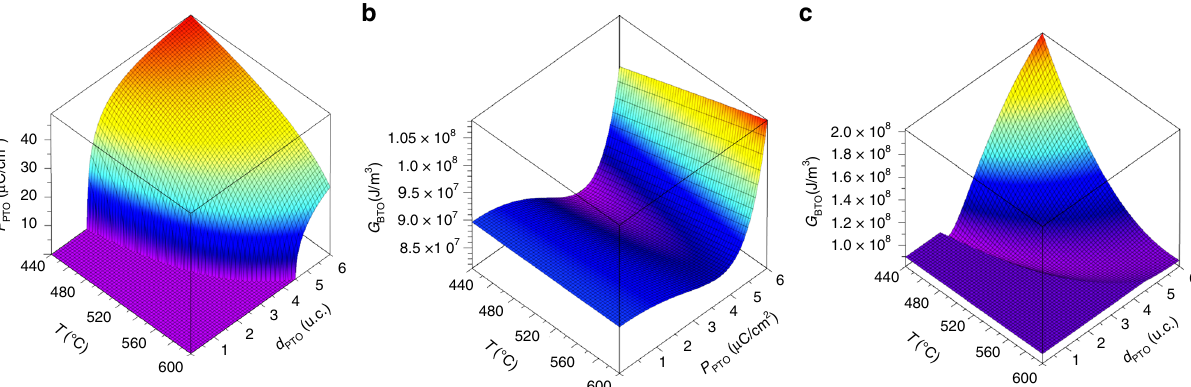
Fig. 2 Explanation of growth rate through free energy of BTO. Explanation of growth rate through free energy of BTO: a Polarization of PTO as a function of temperature and PTO thickness d , b Free energy of BTO as a function of temperature and polarization, which in our model is assumed to be the polarization of the underlying PTO, c Free energy of BTO as a function of temperature and PTO thickness